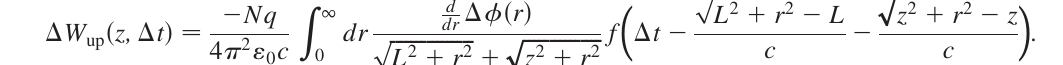
p ffiffiffiffiffiffiffiffiffiffiffiffiffiffiffi z 2 þ r 2